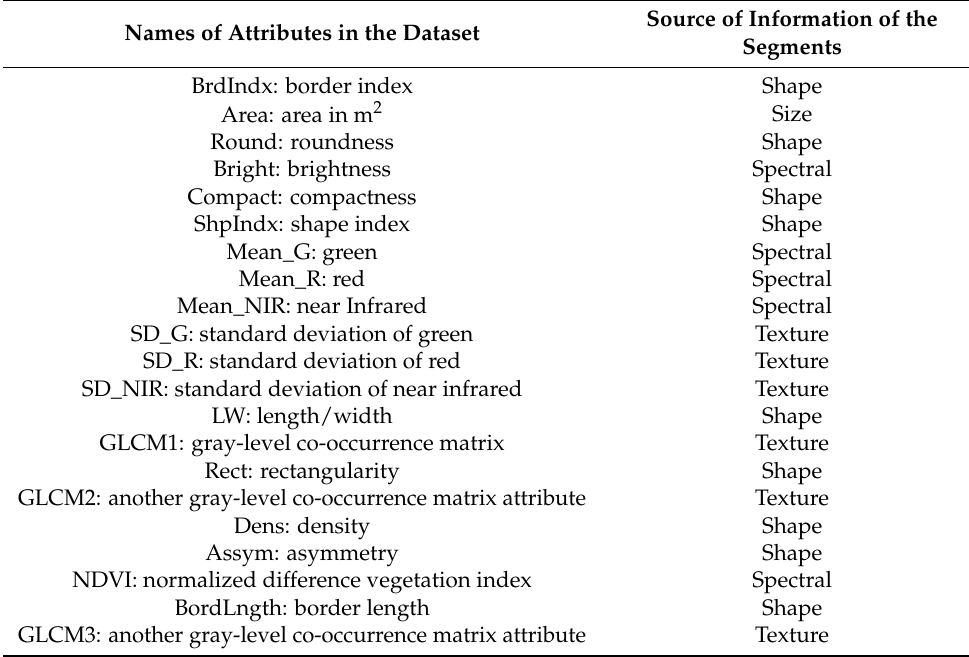
Table 11. Number of data points concerning nine forms of land cover in urban land cover dataset. Names of the Land Cover in the Dataset No. of Data Points Trees (Class